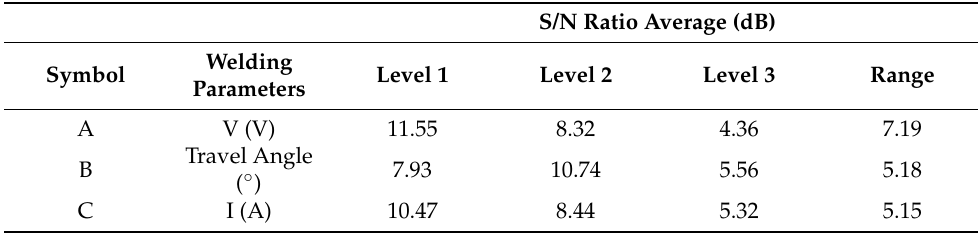
Table 7. S/N ratio response for weld root penetration.